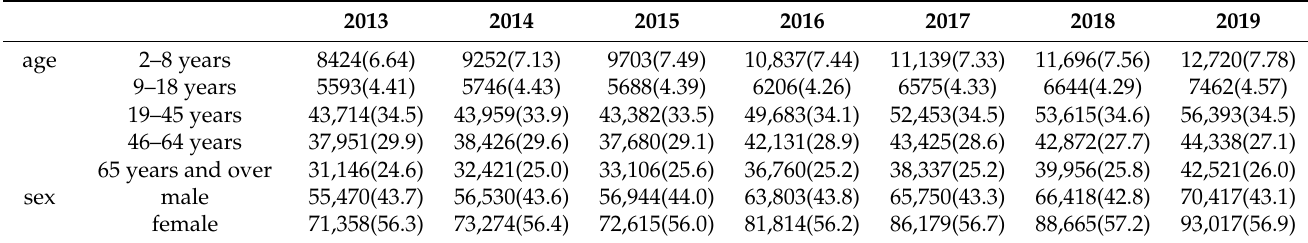
Table 1. Demographic characteristics of study sample from 2013 to 2019 1